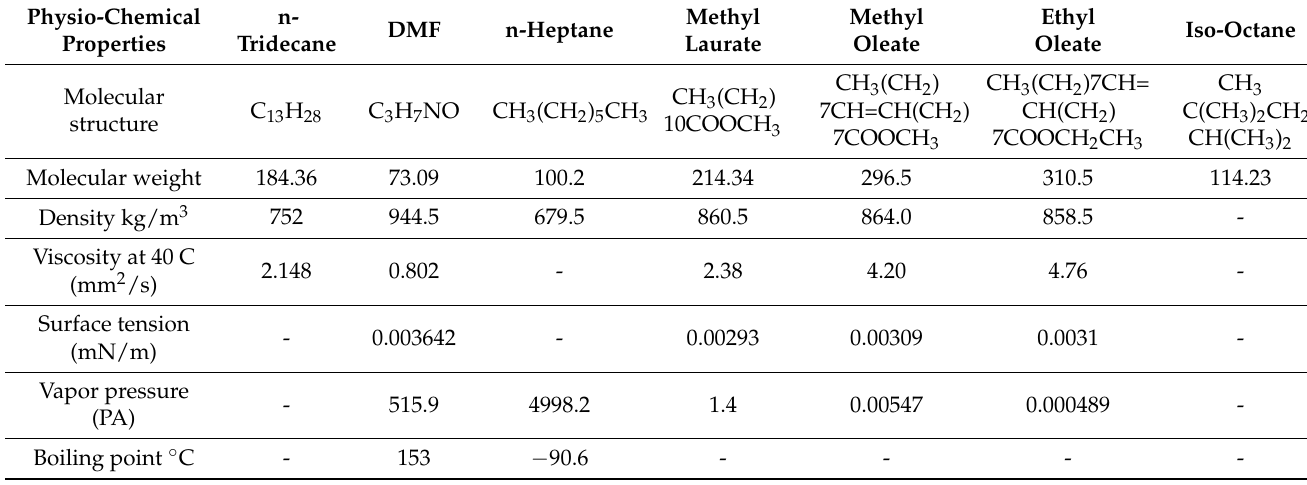
Table 7. Physio-chemical properties of ester, aliphatic and aromatic compounds used as addi- tives